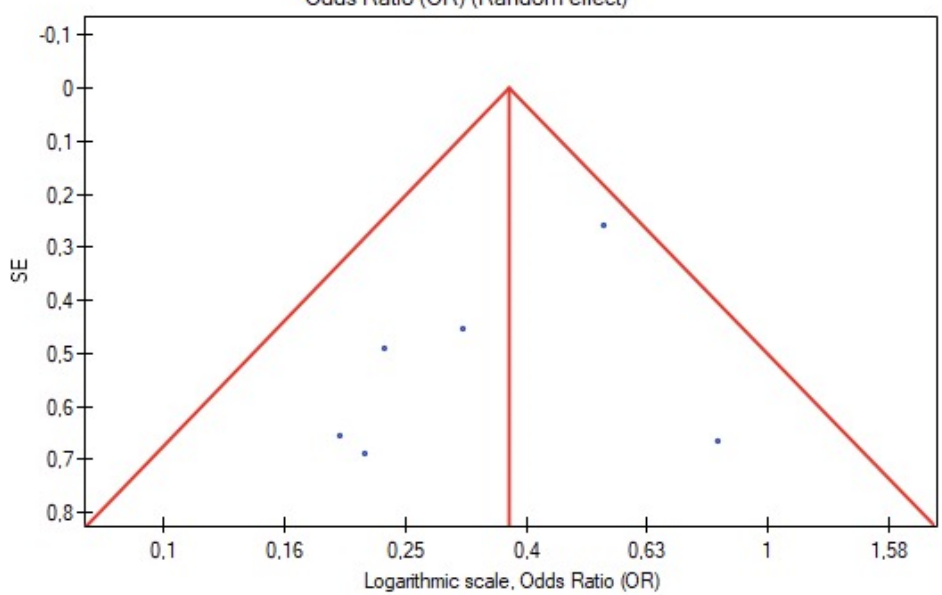
Figure 8. Funnel plot for the occurrence of type II endoleak.